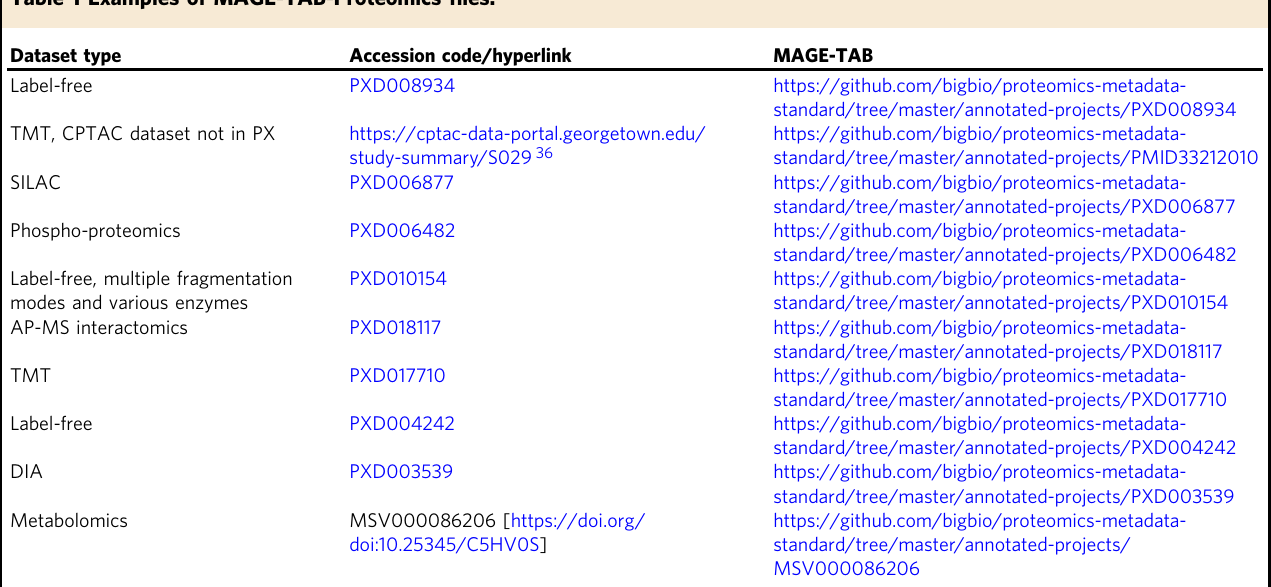
Fig. 3 Using MAGE-TAB-Proteomics for dataset annotations. a Quanti fi cation and data-acquisition methods used in the public datasets that have been annotated with MAGE-Tab-Proteomics by July 2021. b Tools and libraries for the validation and conversion of MAGE-TAB-Proteomics fi les. Table 1 Examples of MAGE-TAB-Proteomics fi